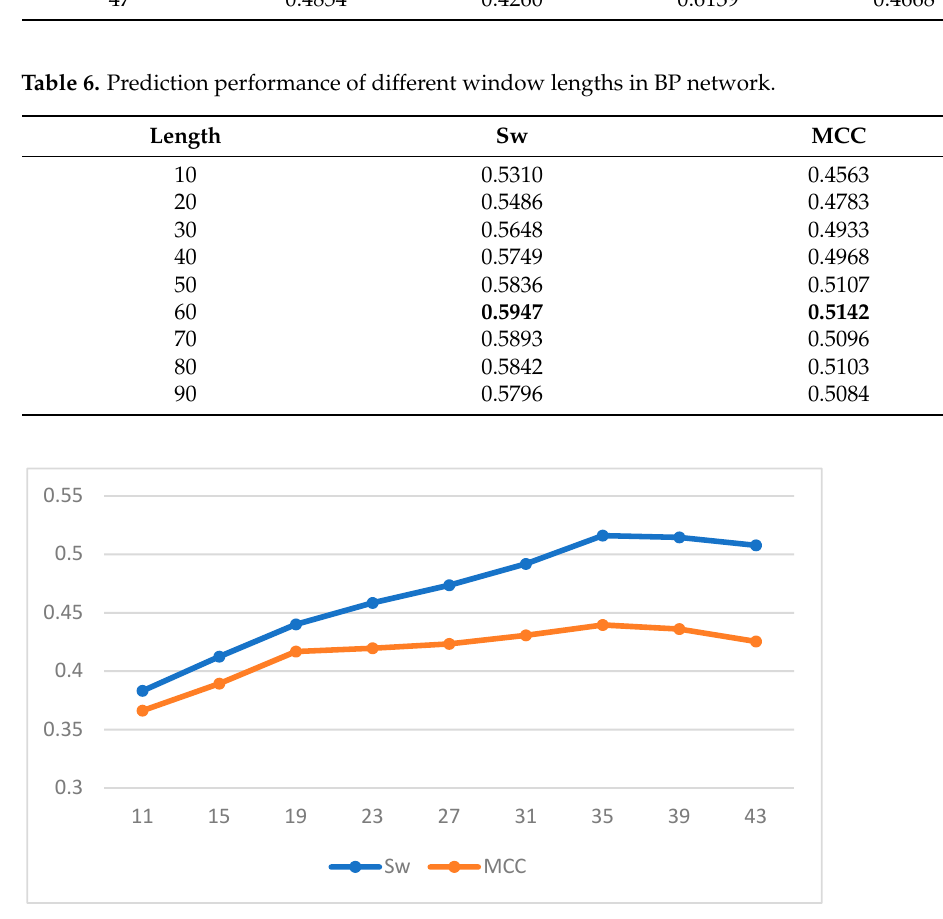
Figure 2. Effect of different window length on prediction performance of LDA.